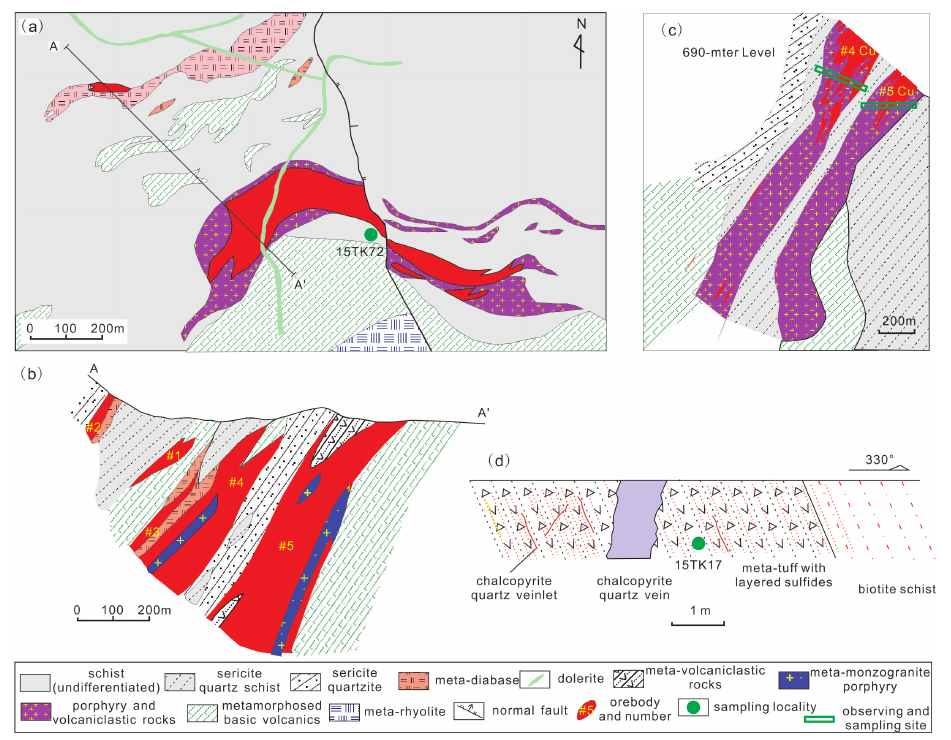
Figure 2. ( a ) Geologic map of the Tongkuangyu copper deposit showing primary lithologies, structure, and ore bodies; ( b ) A to A’ cross section showing the attitudes of the ore-hosting rocks and ore bodies; ( c ) A plenary geological map of the underground working at the level of 690 m with locations for observing and sampling; and ( d ) A field sketch of the underground tunnel at the level of 554 m with locations for observing and